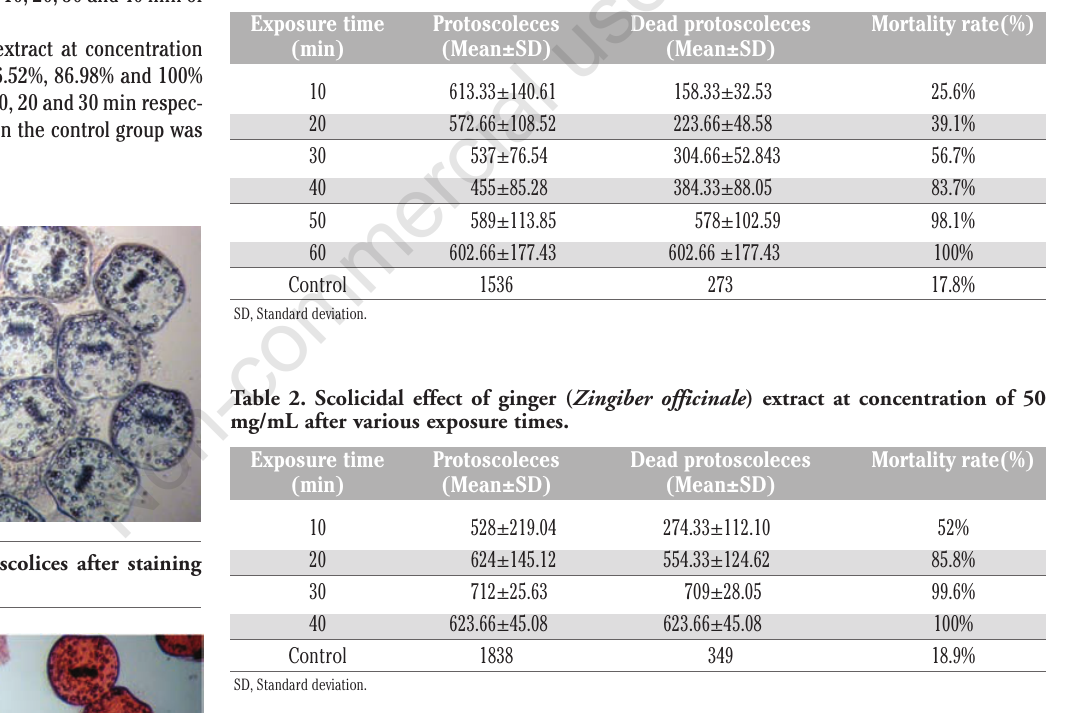
Table 1. Scolicidal effect of ginger ( Zingiber officinale ) extract at concentration of 25 mg/mL after various exposure times.